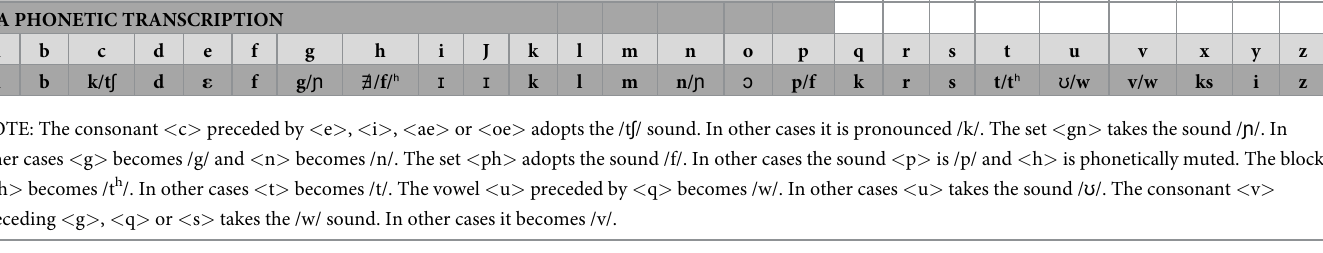
Table 4. Latin language. Latin alphabet (lowercase letters) and phonetic transcription (IPA symbols). LATIN ALPHABETIC CHARACTERS (LOWERCASE) IPA PHONETIC